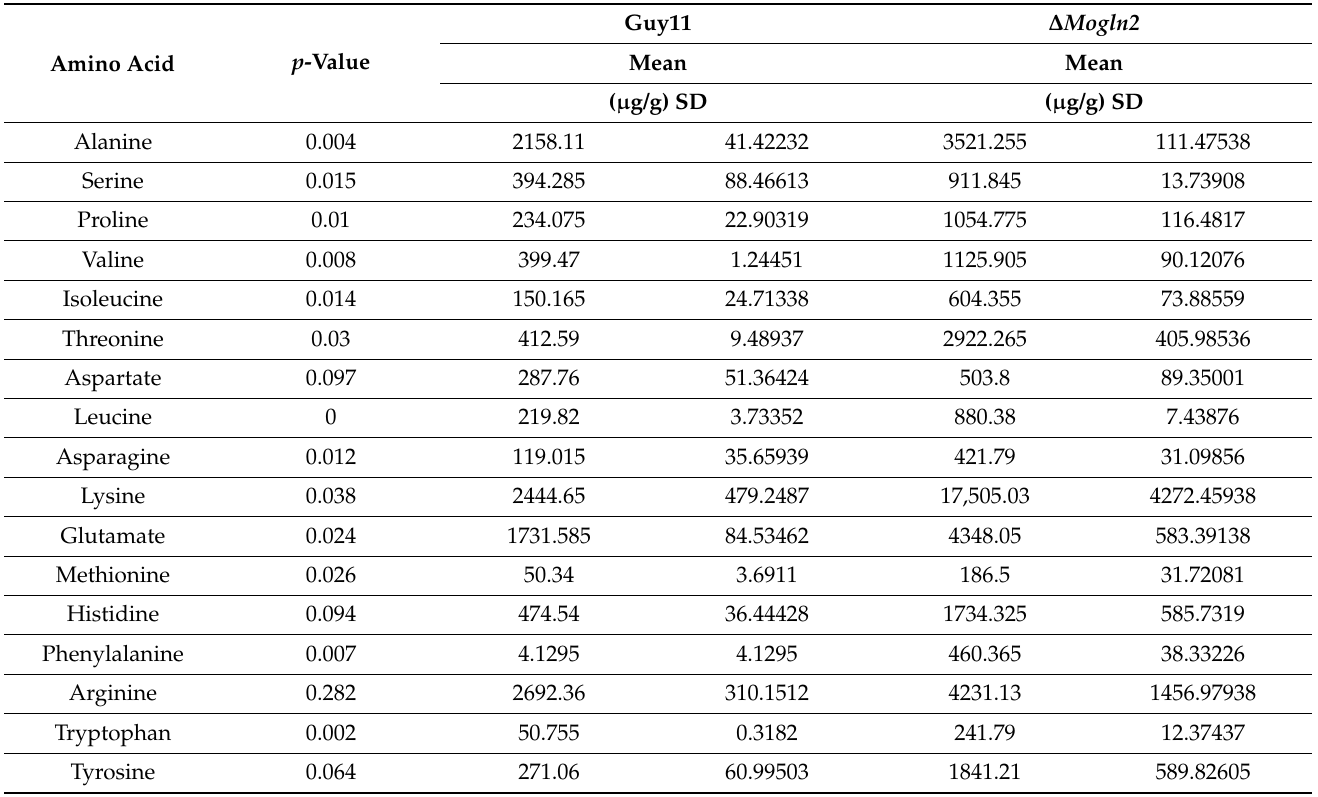
Table 1. Intracellular free amino acids.